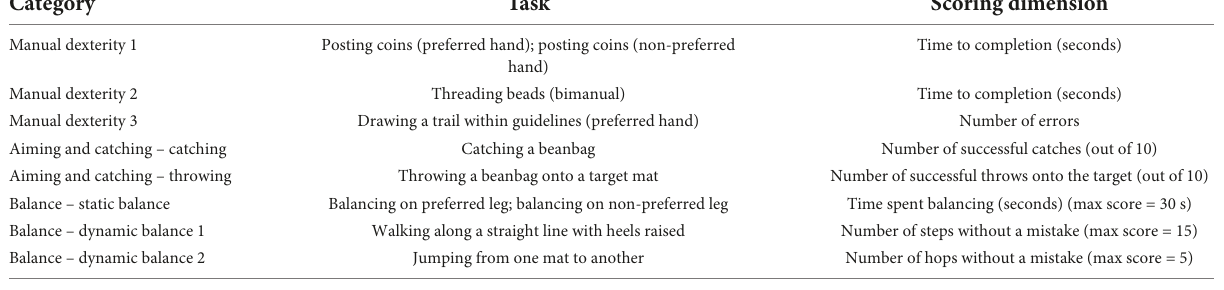
TABLE 2 Clinical characteristics of participants separated by